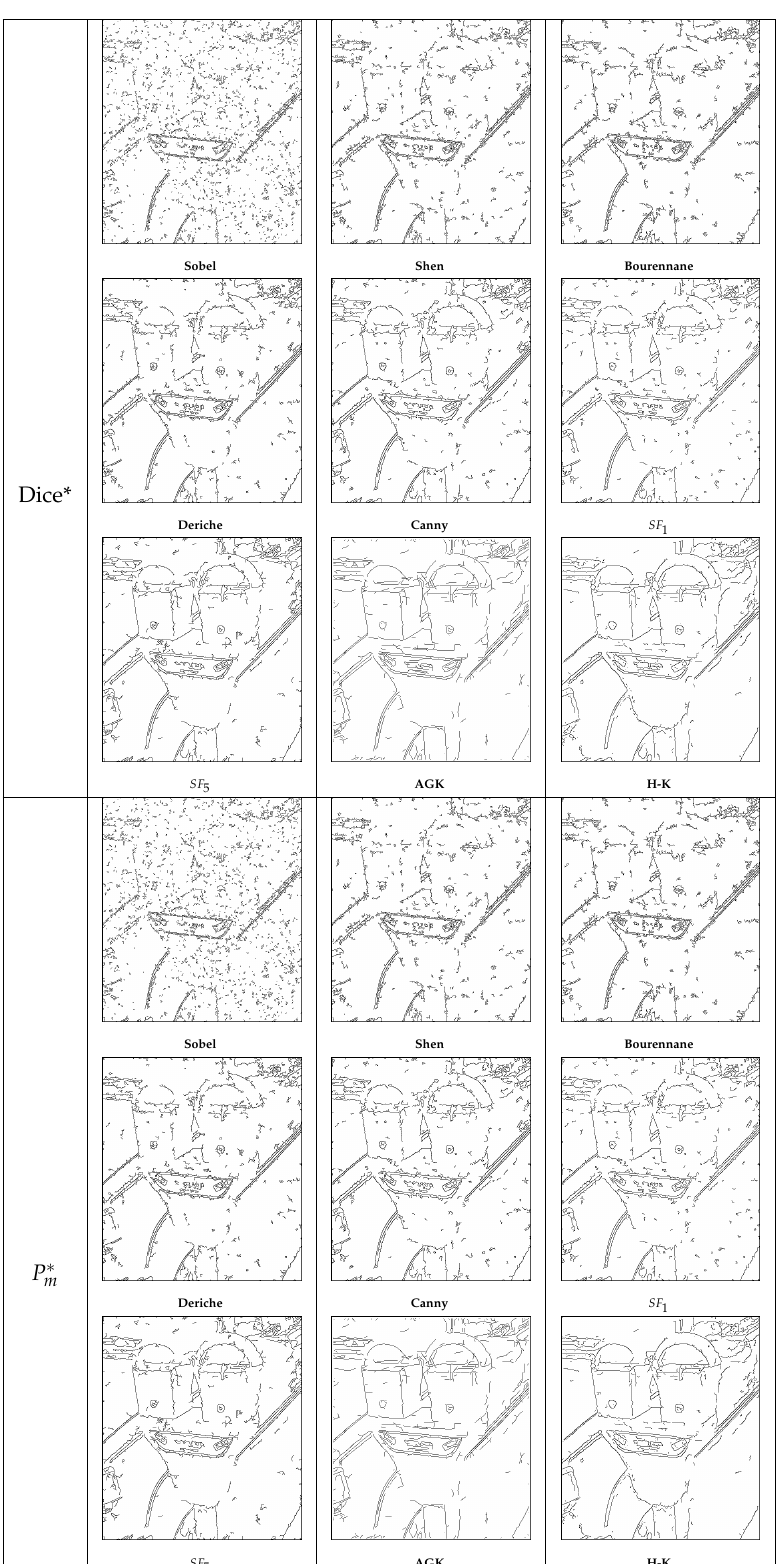
Figure 34. Ideal segmentations for several edge detectors on image parkingmeter, PSNR = 14